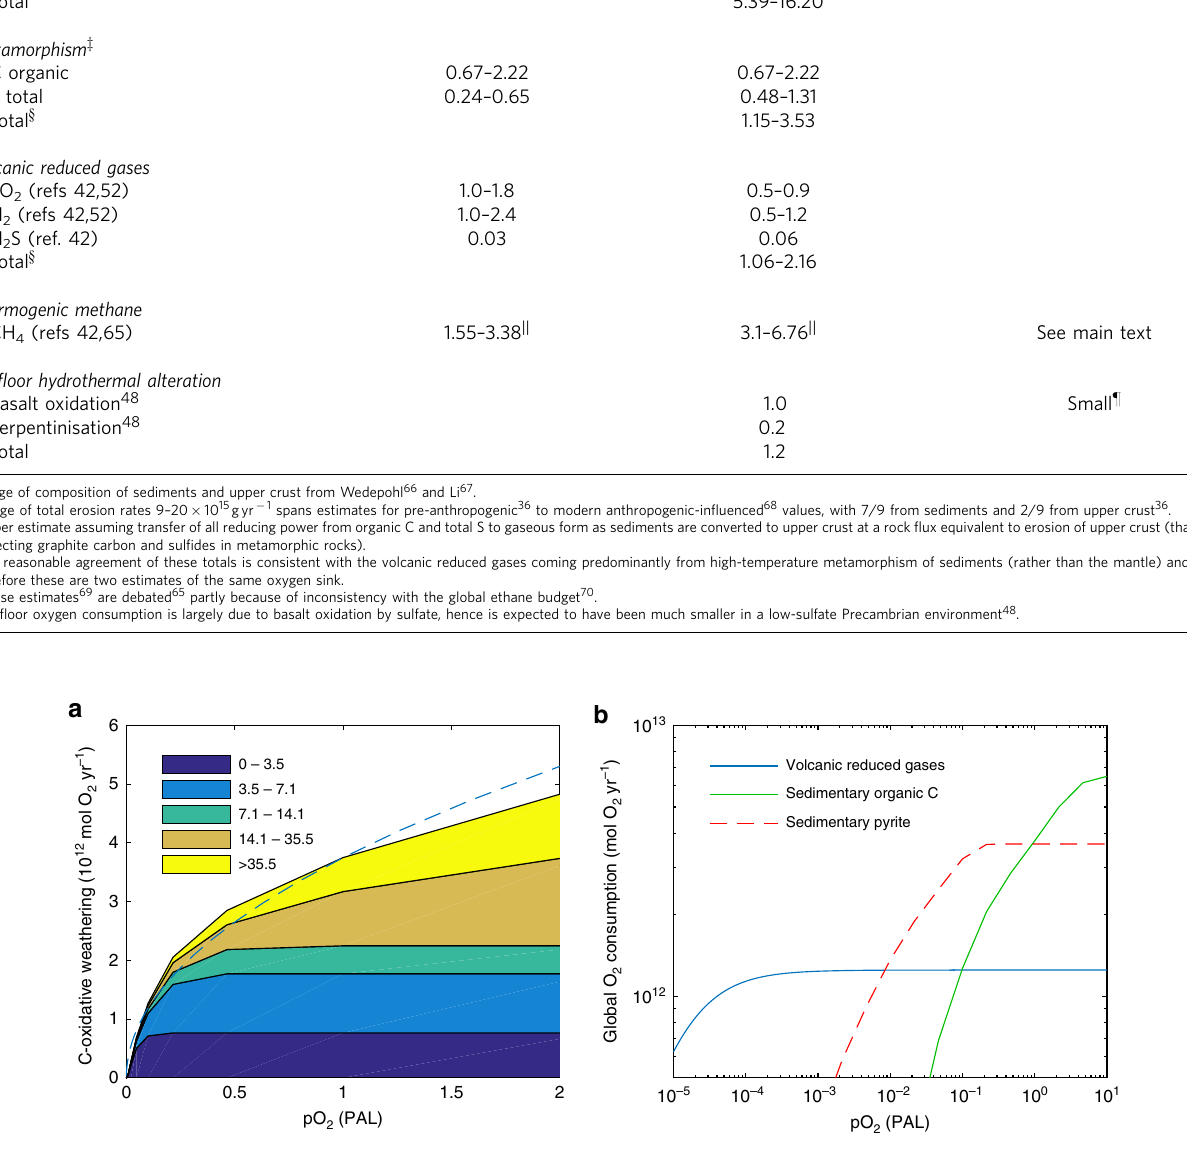
Figure 2 | Sensitivity of atmospheric oxygen sinks to oxygen concentration. ( a ) Oxidative weathering rate for carbon, from the shale reaction-transport model of Bolton et al. 32 integrated over a distribution of land-surface erosion rates 44 , showing contributions to carbon oxidation from bins for erosion rate (cmkyr (cid:2) 1 ). Dashed line shows pO 2 0.5 dependency 45 assumed in some biogeochemical models 11,25 . ( b ) Global integrated oxygen consumption from volcanic reduced gases (blue), sedimentary organic carbon oxidation (green) and sedimentary pyrite oxidation (dashed red). The organic carbon and pyrite results are from the modelling herein, whereas the volcanic reduced gas consumption is a schematic curve to show pO 2 sensitivity at pre-Great Oxidation Event levels ( r 10 (cid:2) 5 PAL) but not at Proterozoic levels 40,42 (hence this process cannot help explain Proterozoic atmospheric oxygen regulation).